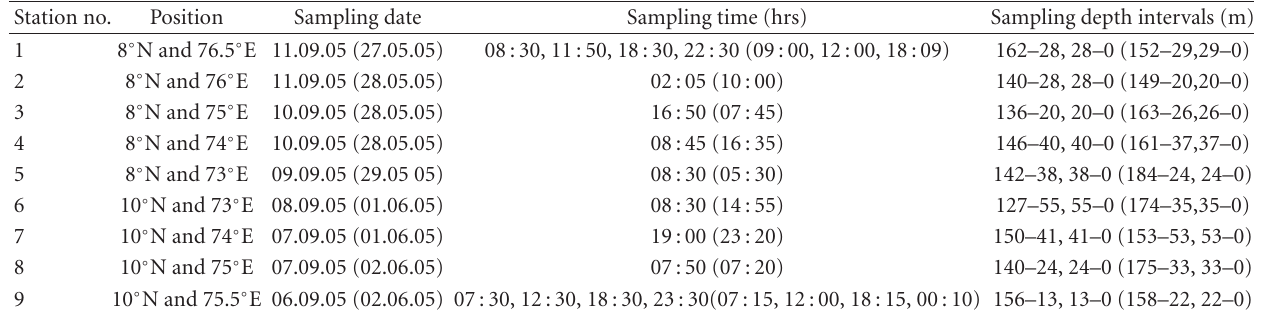
Table 1: Details of sampling during early and peak phases of summer monsoon 2005. (Values in the parenthesis denotes the early phase.) Station